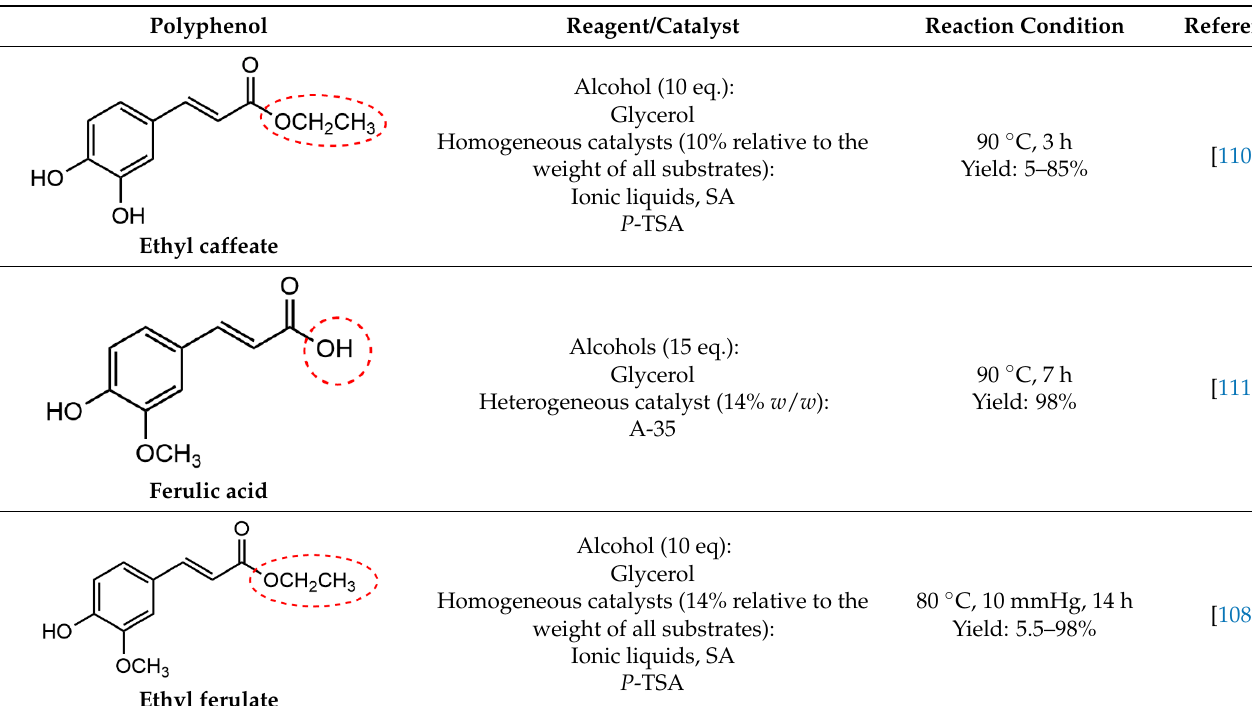
Homogeneous catalysts (14% relative